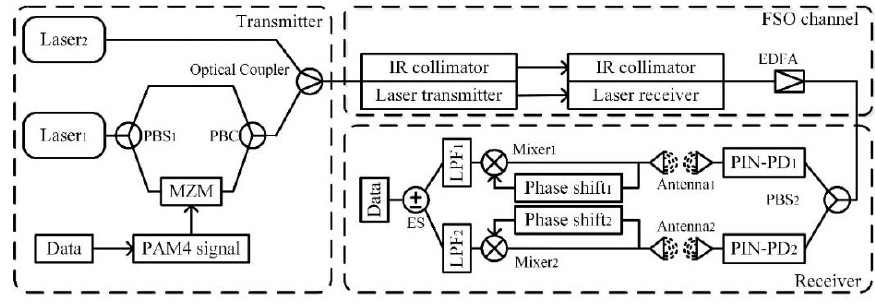
Fig. 1. Schematic diagram of system